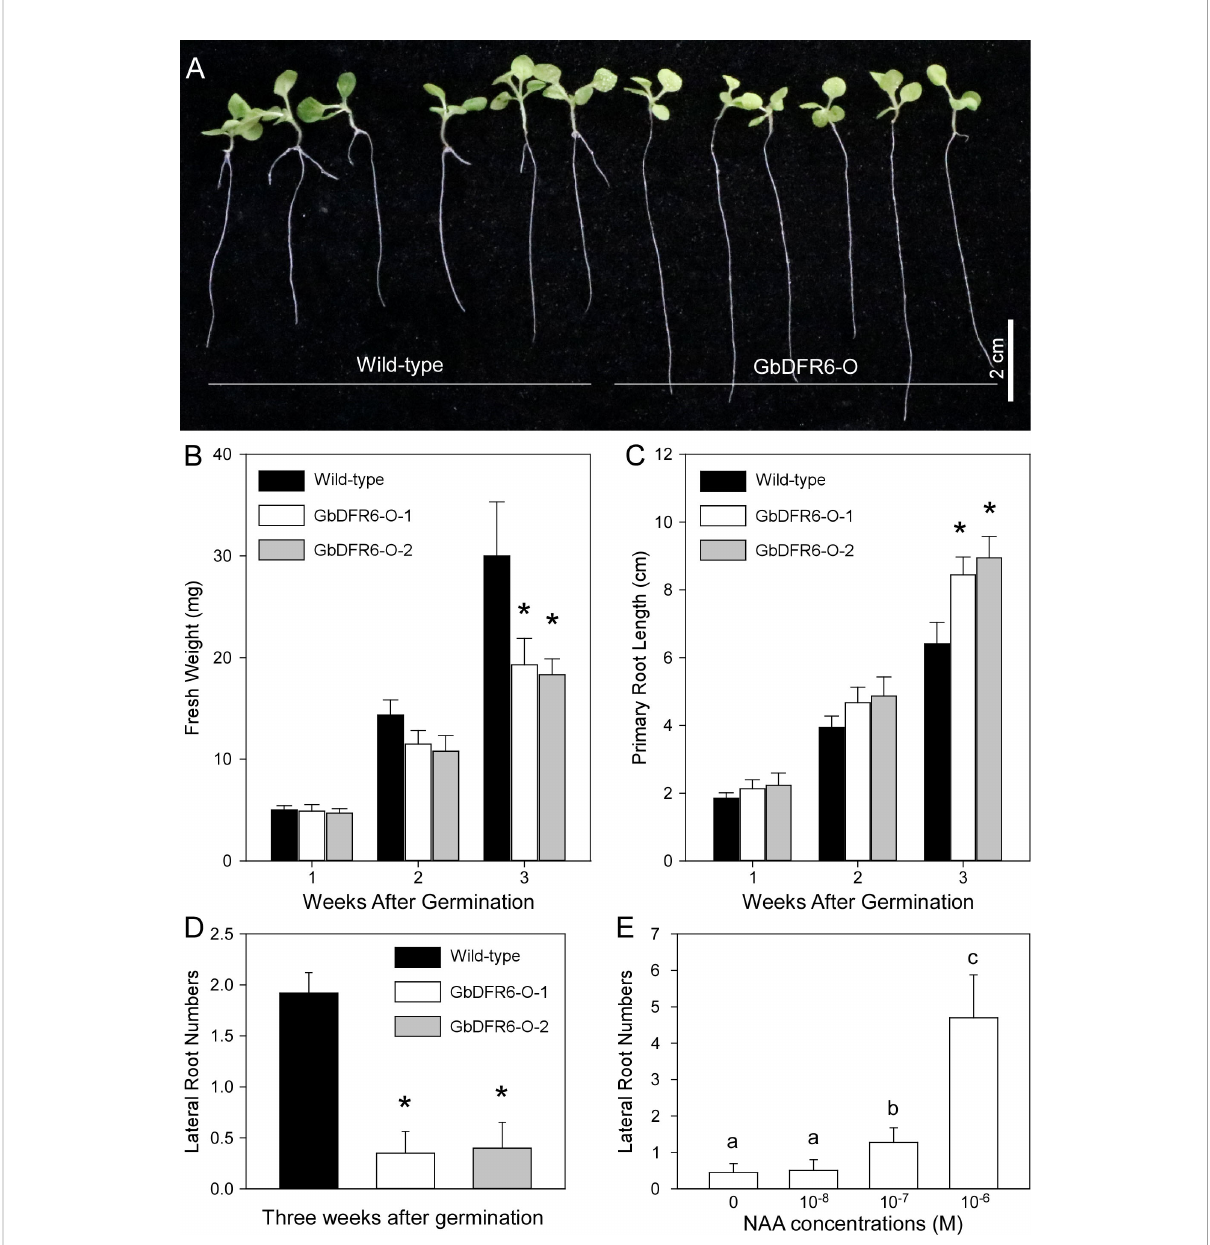
FIGURE 1 A comparison of growth parameters between wild-type and transgenic tobacco seedlings. (A) Three-week-old wild-type and transgenic tobacco seedlings. Bar = 2 cm. (B) A Comparison of fresh weights between wild-type and transgenic tobacco seedlings during the fi rst three weeks after germination. (C) A comparison of primary root lengths between wild-type and transgenic tobacco seedlings during the fi rst three weeks after germination. (D) A comparison of lateral root numbers between wild-type and transgenic tobacco seedlings three weeks after germination (data are presented as means ± SD; n = 20; * indicates signi fi cant differences, P < 0.01; Student ’ s t -test). SD, standard deviation. (E) The induction of lateral root of transgenic tobacco seedlings by exogenous auxin treatment (n = 20; Different letters indicate signi fi cant differences, P < 0.01; Student ’ s t